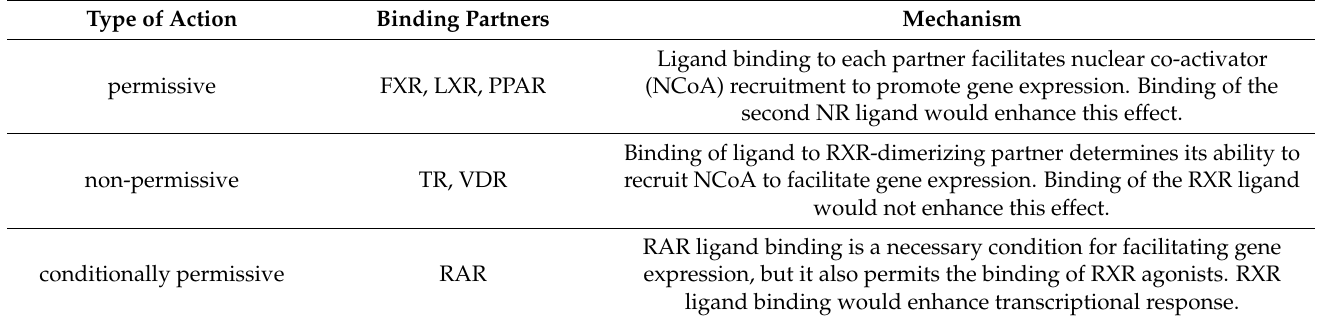
Table 2. Nuclear receptors involved in the metabolism of carotenoid metabolites